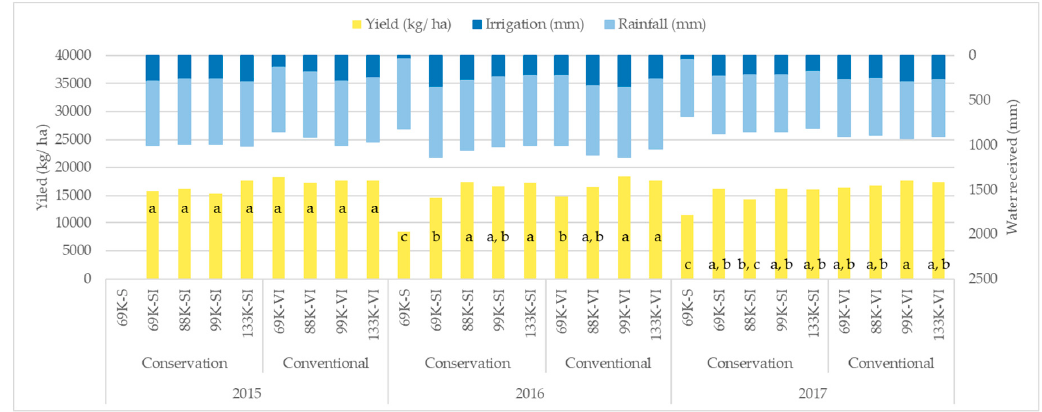
Figure 11. Yield (kg/ha) produced in SIRP field by each treatment and the total amount of water (mm) received by each treatment per growing season.